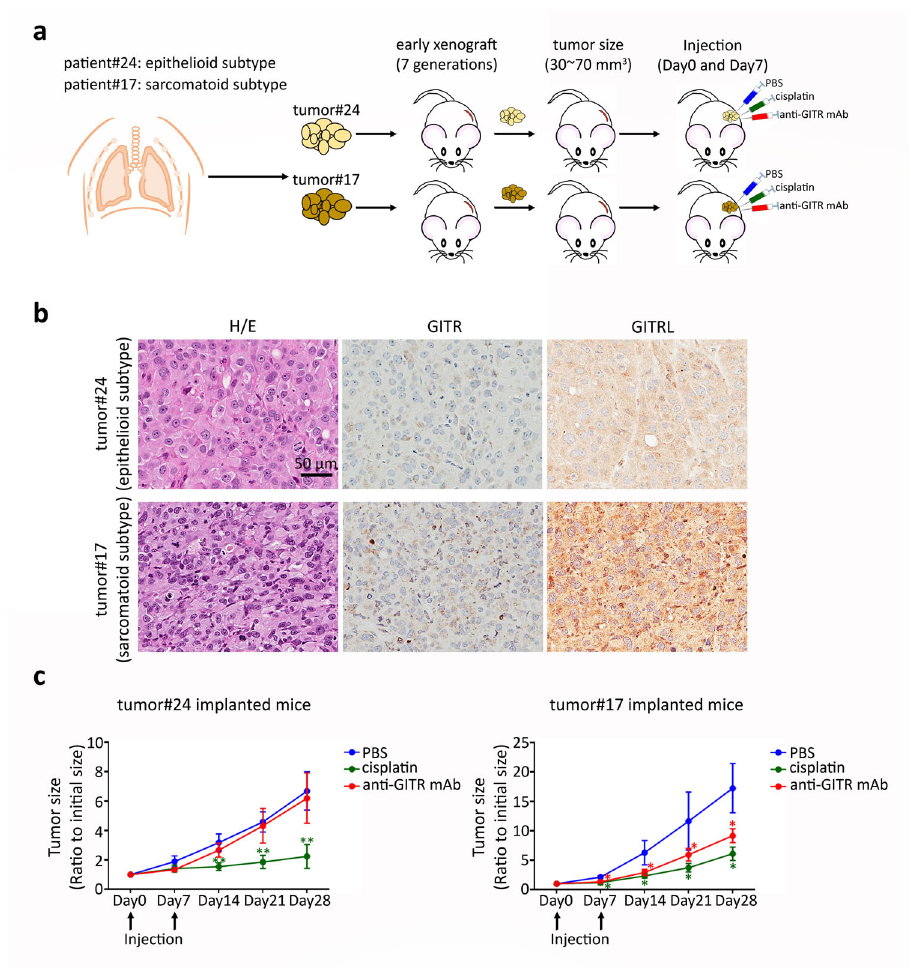
Fig. 5 Interruption of GITR/GITRL signaling in patient-derived sarcomatoid xenograft inhibits tumor growth. a Tumours were collected from clinical mesothelioma patients with epithelioid MPM subtype and sarcomatoid MPM subtype and subcutaneously implanted into NOD/SCID mice on right fl ank region to generate xenografted mice. Mice with xenografted tumours that were the size of 30 – 70 mm 3 received intraperitoneal PBS on day 0 and 7, 5 mg/ kg cisplatin on day 0 and 7, or 400 µ g anti-GITR mAb on day 0 and 200 µ g on day 7. b Representative images of H&E stain for morphologic analysis and immunohistochemistry staining for GITRL and GITR expression. c Tumor size was decreased in sarcomatoid xenograft mice treated with cisplatin ( n = 4) or anti-GITR mAb ( n = 4) and decreased in epithelioid xenograft mice treated with cisplatin ( n = 5), whereas anti-GITR mAb group ( n = 4) had no effect on tumor size compared with PBS group ( n = 4 of sarcomatoid xenograft, n = 6 of epithelioid xenograft). * P < 0.05; ** P < 0.01 vs PBS injected group, determined by Mann – Whitney